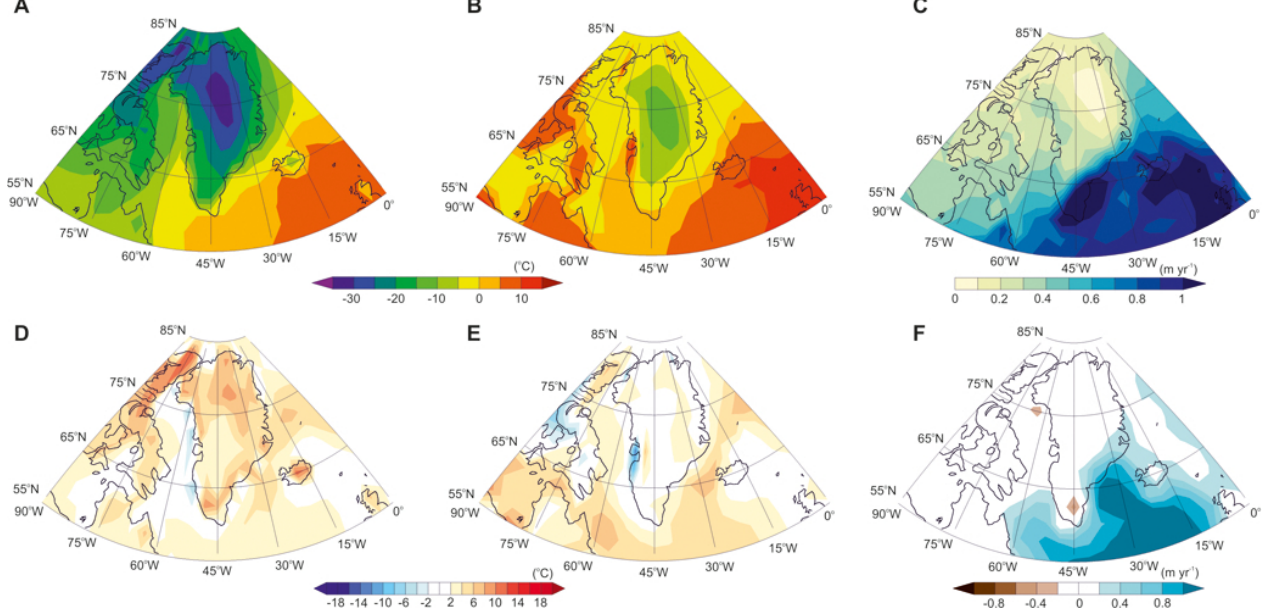
Fig. 1. Control phase driving climatologies. HadAM3 modelled (a) mean annual and (b) summer (July) surface air temperature ( ◦ C), (c) mean annual precipitation rate (myr − 1 ) and the differences between NCEP reanalysis data and HadAM3 (NCEP-HadAM3) for (d) annual mean and (e) summer surface air temperature ( ◦ C) and (f) precipitation (myr − 1 ) over Greenland. Note that NCEP reanalysis data were interpolated to the HadAM3 GCM grid before calculating the